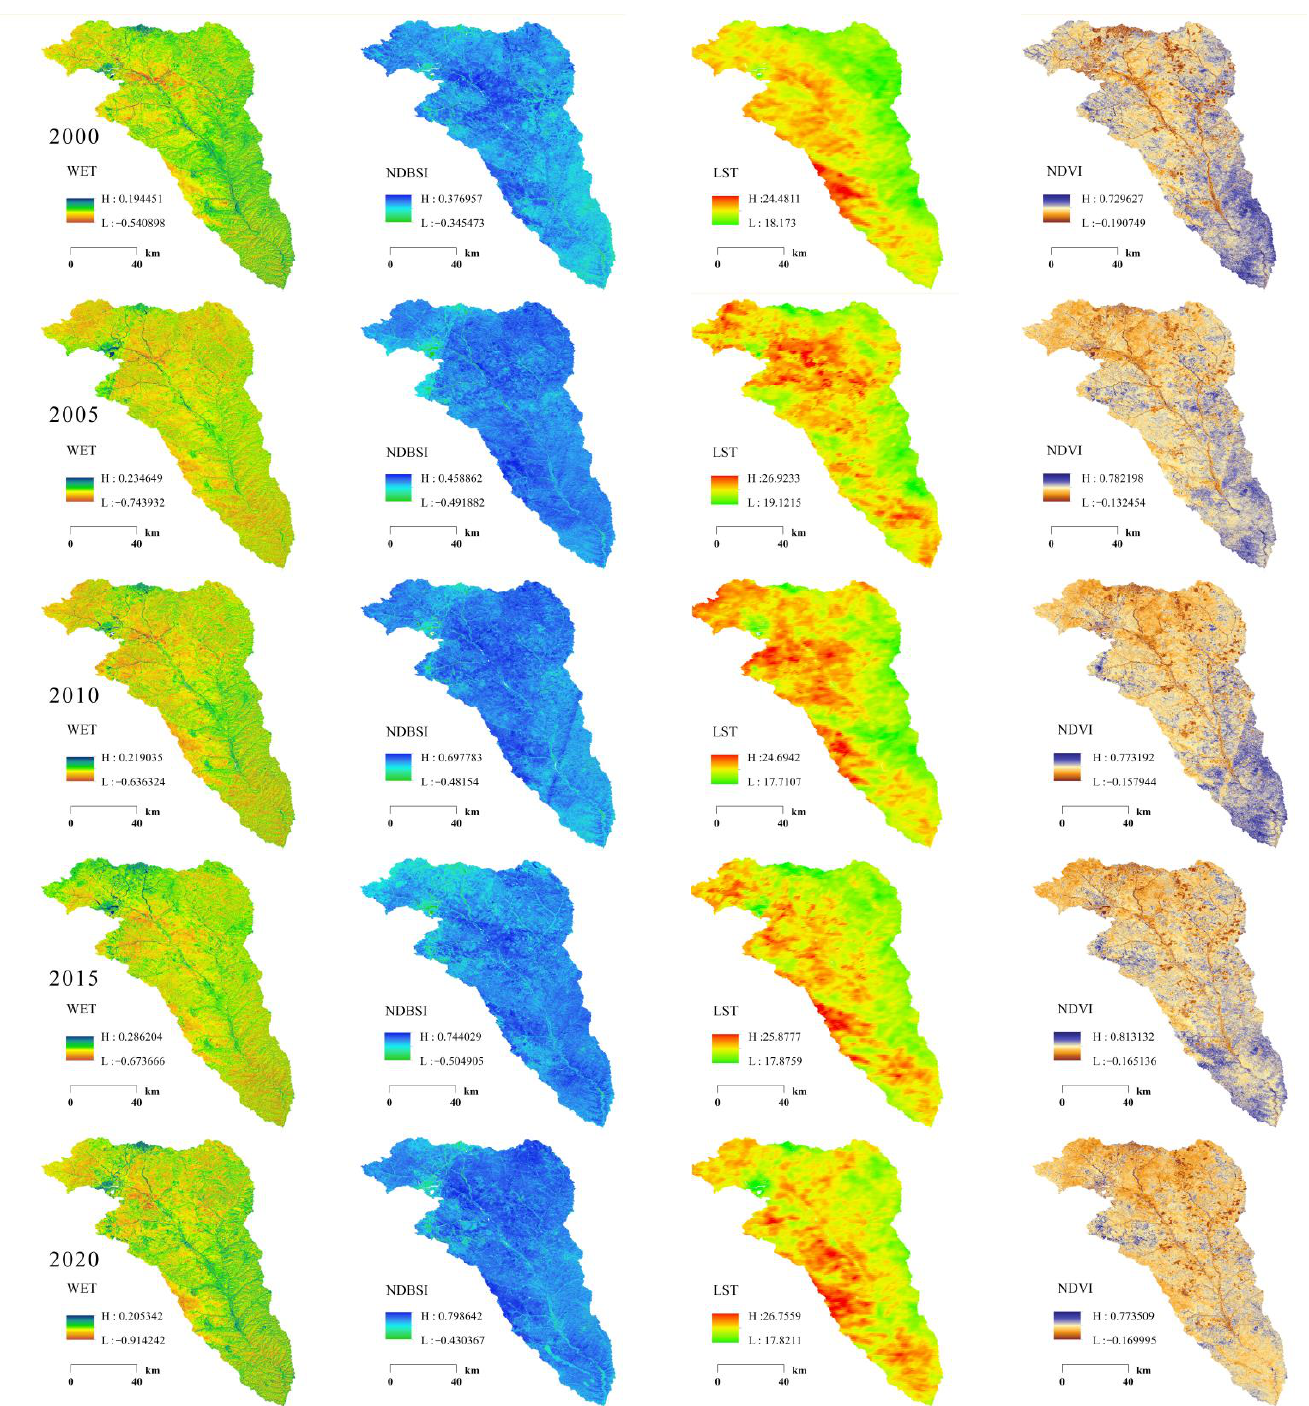
Figure 3. Temporal and spatial distribution of various indicator results in Kuye River Basin .